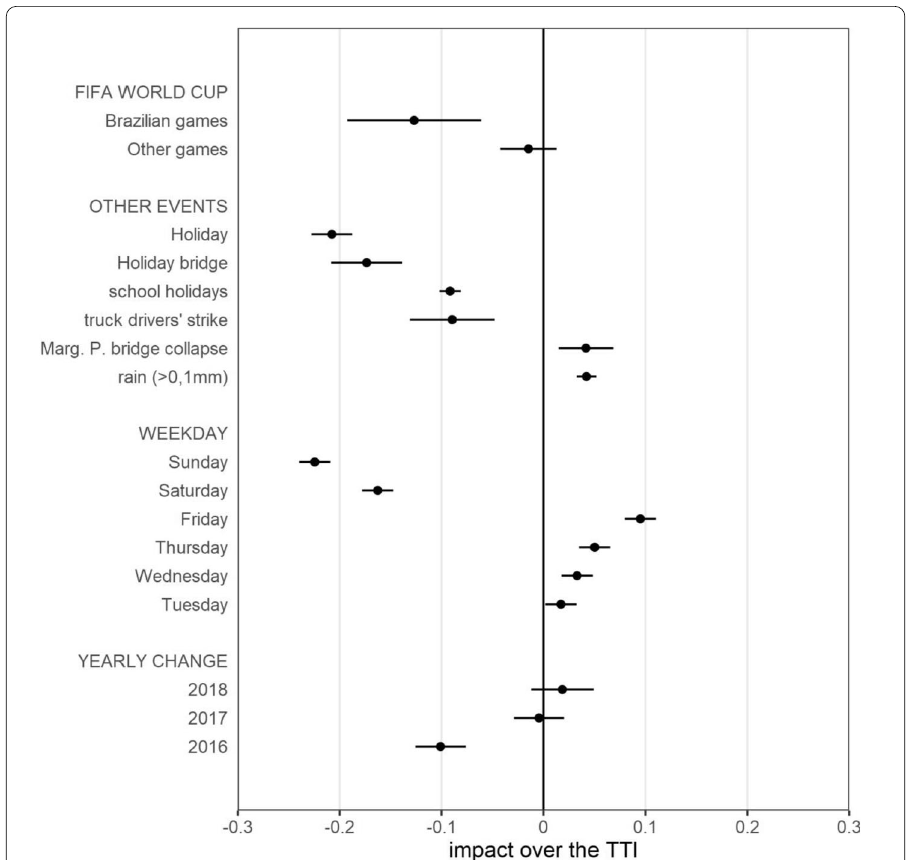
Figure 7 Regression results: impacts of different events on the RMSP daily congestion index. Each point represents the value of both variables for the period of a day observed between 2016–2018. The dashed red line is the prediction of the bivariate model that estimates the congestion index based on the kilometers of slowness plus an intercept